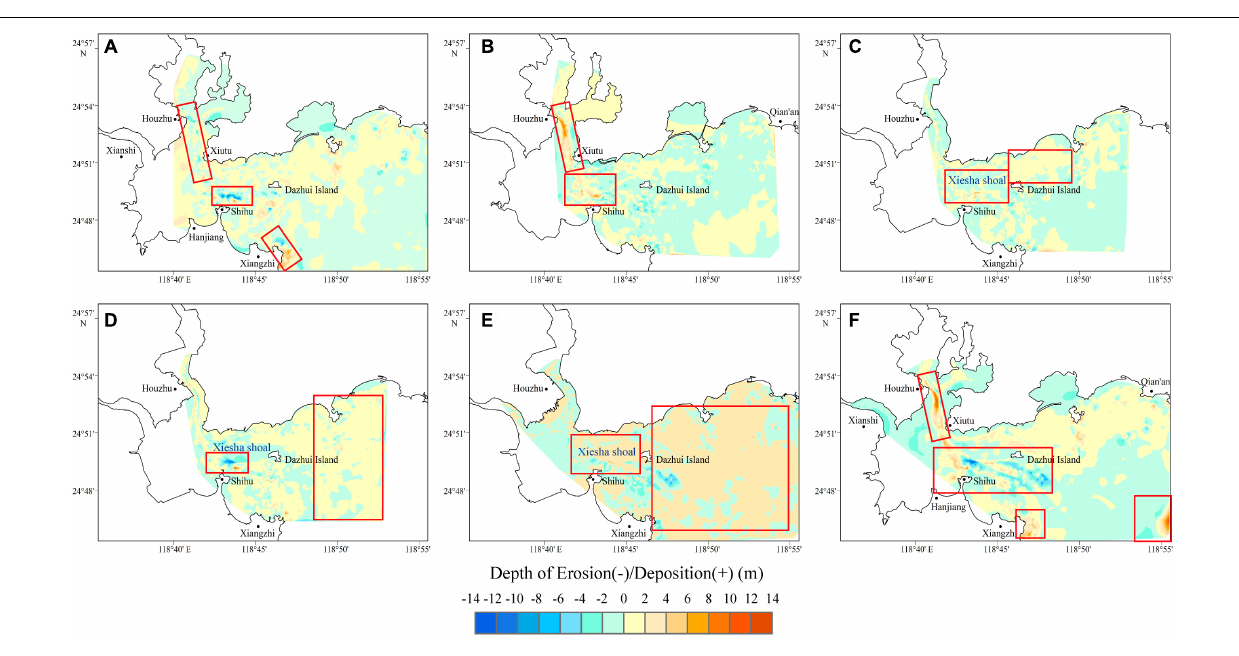
FIGURE 4 | Variation of water depth in Quanzhou Bay from 1954 to 2017. (A) 1954–1968; (B) 1968–1989; (C) 1989–1998; (D) 1998–2007; (E) 2007–2014; (F) 1954–2014. Most of the blank areas in the bay were mudflats over 0 meters, and the blank area at the entrance of the bay was the repeated bathymetric